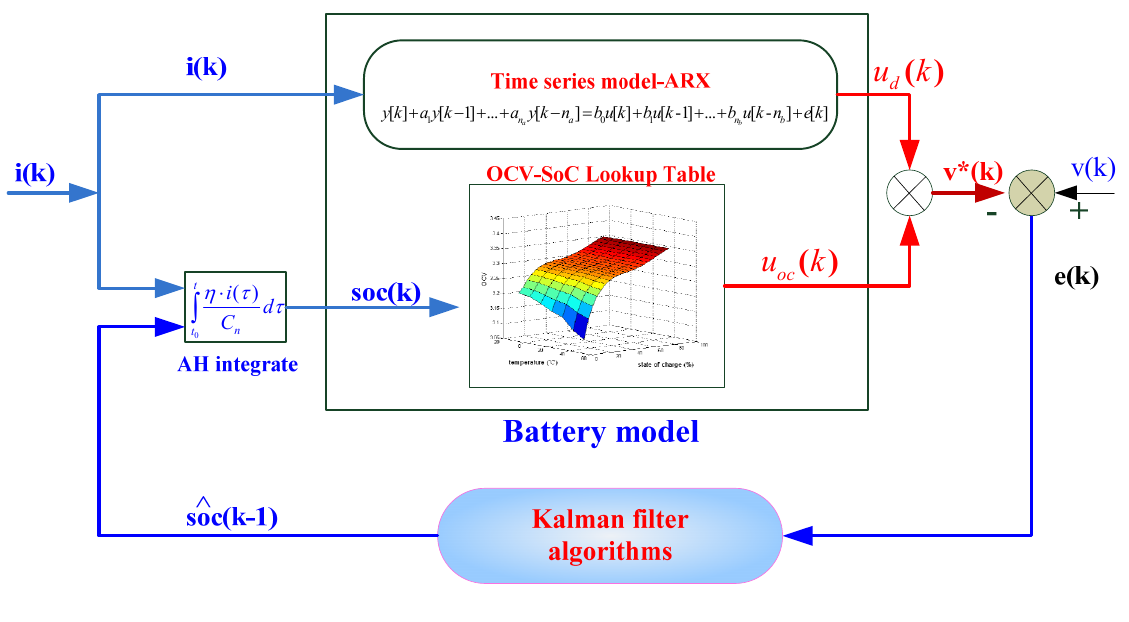
Figure 16. Diagram of EKF-based SOC estimation